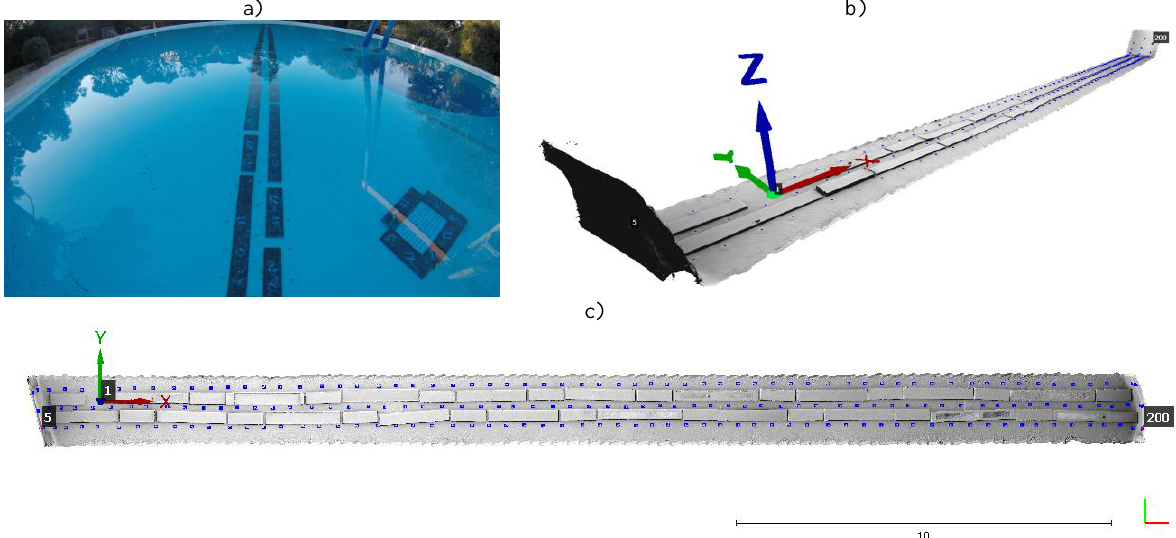
Figure 5. A panoramic view of the pool transect (a) and the reference mesh built using full resolution images with superimposed coordinate reference system